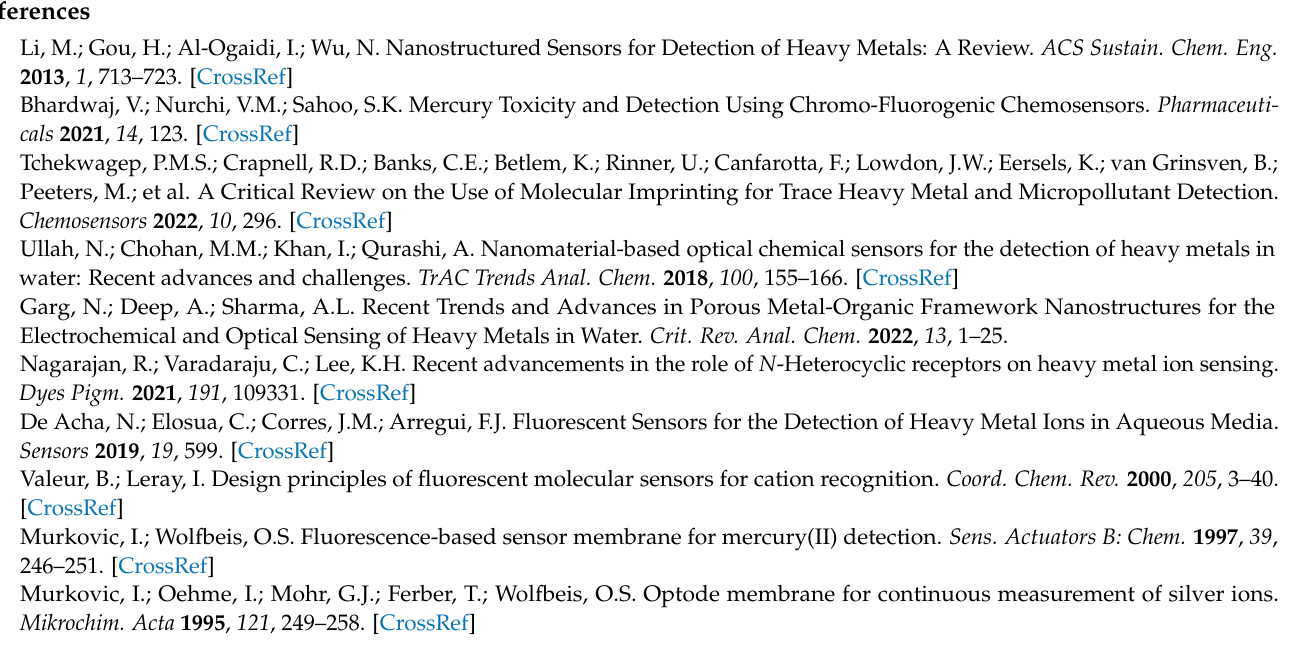
plot in linear range for NI-1 binding with (a) Cu 2+ (b) Hg 2+ ; Figure S8: Dependence of fluorescence intensity of NI-1 (5.00 × 10 − 7 M) in MeOH/buffer pH 5.5 ( v / v , 1/2) at 523 nm on the ion concentra- ratio of the fluorescence intensities ( F 0 / F ) of NI-1 against the increasing concentration of (a) Cu 2+ and (b) Hg 2+ ions in linear range; Figure S10: UV-Vis spectra of NI-2 upon the addition of Hg(II) ions; Figure S11: Job’s plot fluorescence intensity at 525 nm on the molar content of NI-2 in presence of Hg 2+ ions at a total concentration of 5.00 × 10 − 6 M; The extrapolated directions of intensity dependence on the molar fraction of NI-2 are presented; Figure S12: Benesi–Hildebrand’s plot in linear range for NI-2 binding with Hg 2+ ; Figure S13: Dependence of fluorescence intensity of NI-2 (6.53 × 10 − 6 M) in MeOH/buffer 5.5 ( v / v , 1/2) at 525 nm on the ion concentration in the linear range of dependence for Hg 2+ ion; Figure S14: Reversibility test for NI-2 and Hg(II)